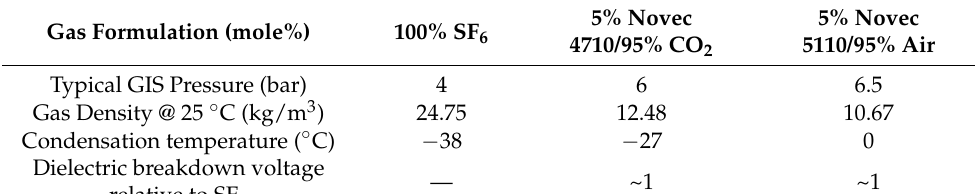
Table 2. Gas mixture properties compared to SF 6 .